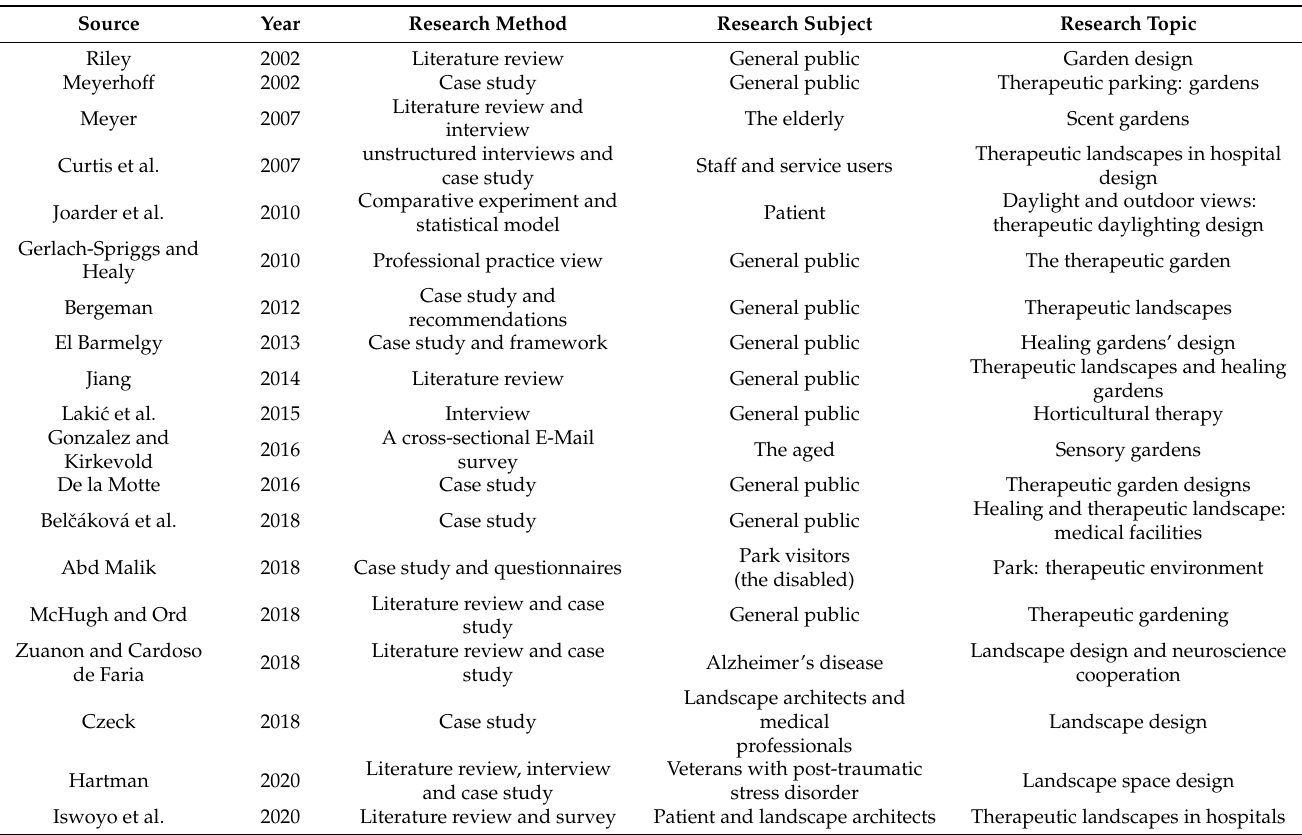
Table 2. Research on the application of TD in the field of garden-based